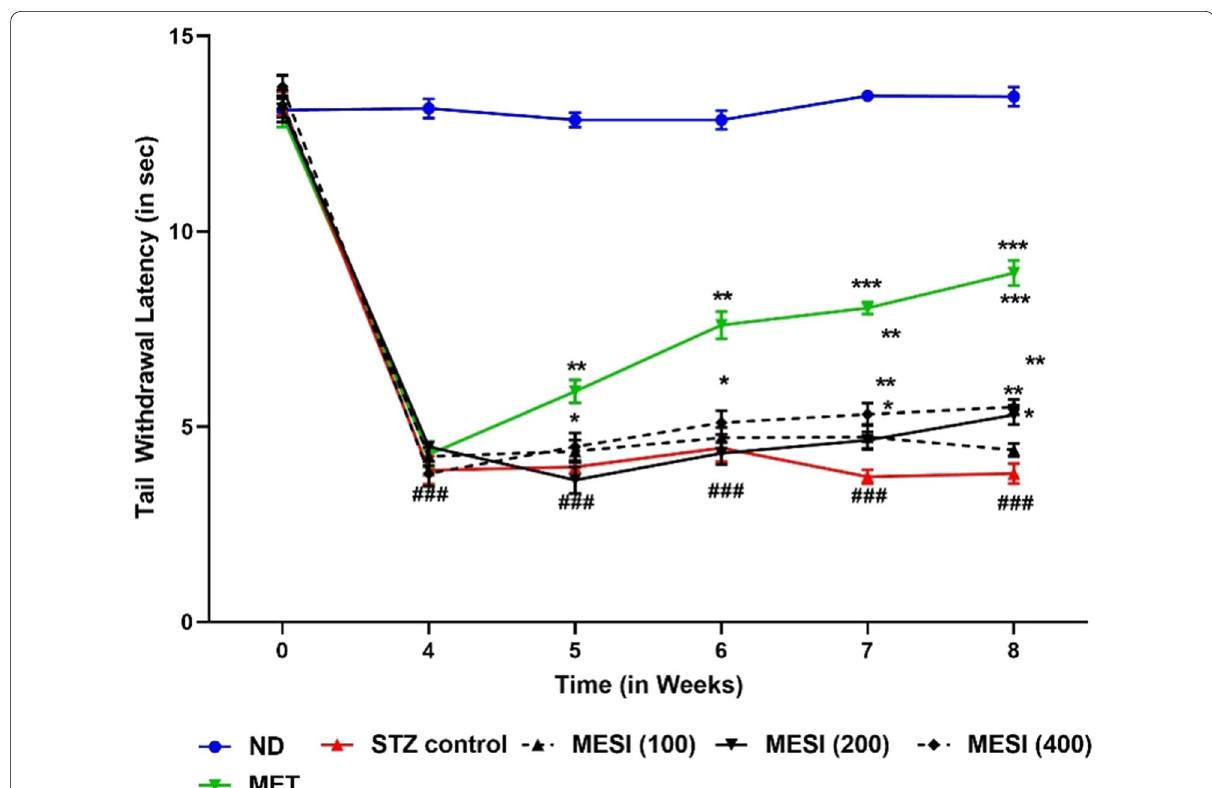
Fig. 4 Effect of chronic treatment of MESI and metformin on diabetes-induced thermal hyperalgesia in Tail-flick test. Data are expressed as mean SEM ( n 6) and analyzed by two-way ANOVA followed by Bonferroni’s multiple range post hoc test. *P < 0.05 and **P < 0.01 for MESI, and ± = *** P < 0.001 for metformin-treated groups compared to the diabetic (STZ) control group. # # # P < 0.001 for the diabetic (STZ) control group compared to the normal non-diabetic